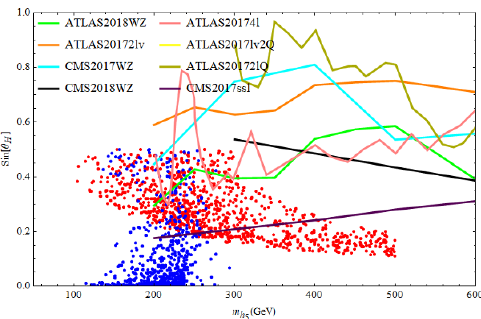
Figure 9 . The v c =T c > 1 viable points in the m h phase transition for the low mass m h